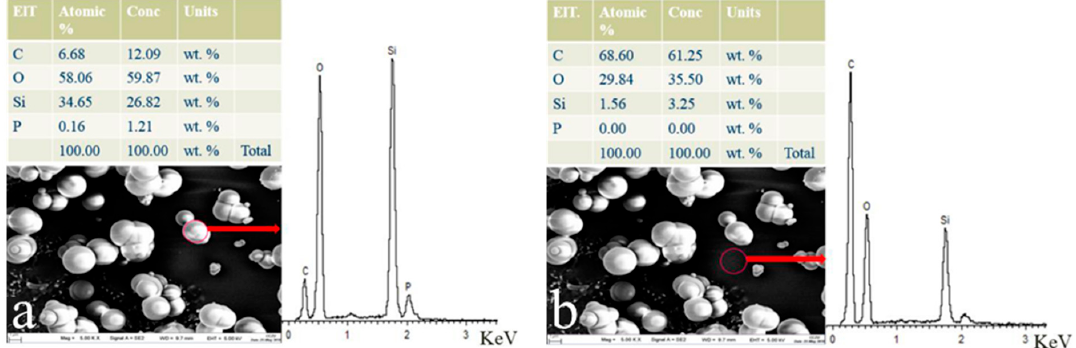
Figure 7. EDS results of the surface for PC / HSPCTP3 composites.